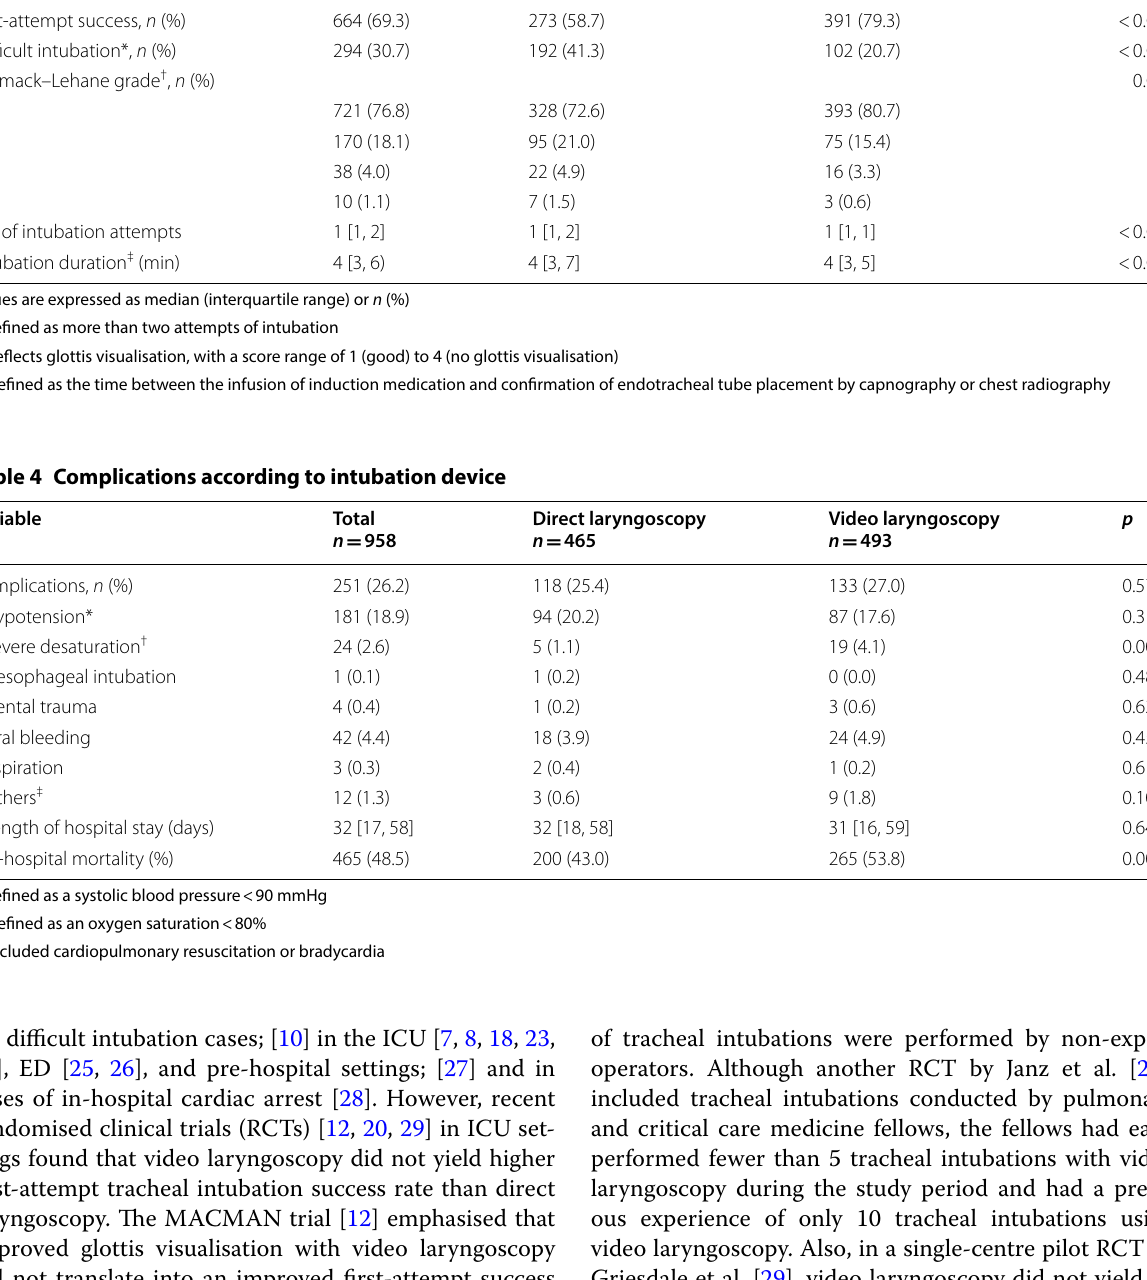
Table 3 Outcomes according to intubation device